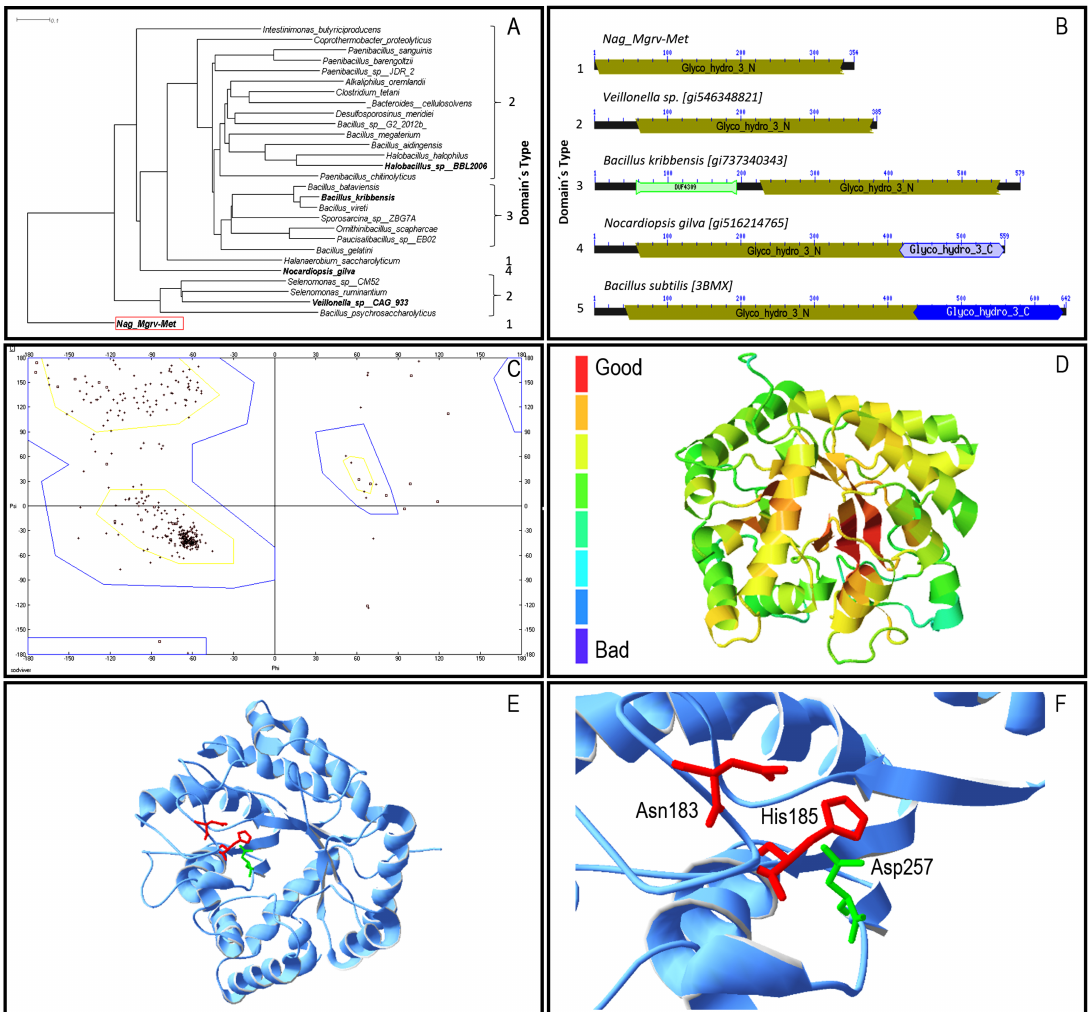
Figure 1. Molecular characterization of protein Nag_Mgrv-Met Panels: ( a ) Phylogenetic tree of Nag_Mgrv-Met and homologues was built using Grishin distance [28] and Fast Tree Minimum Evolution [29]. Scale bar represents number of changes per aminoacid position; ( b ) Domain architecture— domain modular organization predicted by CDART [31]. Numbers indicate proteins; bars in dark grey: relative position and size of GH3_N; light/dark blue: GH3; light green: C terminal and unknown function (DUF4309); ( c ) Ramachandran plot–dyad chain Phi e Psi determined for Nag_Mgrv-Met, predicted by the Phyre’s model, which considered Bacillus subtilis N -acetylglucosaminidase-BsNagZ [35] as template (c3bmxB); ( d ) ProQ2 [36]: quality evaluation of Nag_Mgrv-Met model predicted by Phyre’s model; ( e , f ) Nag_Mgrv-Met–Phyre’s models visualized in Swiss-Model and Protein Data Bank (PDB) viewer v410 [37]. In red the Asparagine 183 (Asn) e Histidine 185 (His) residues, and in green the Aspartate 257 (Asp) residue.